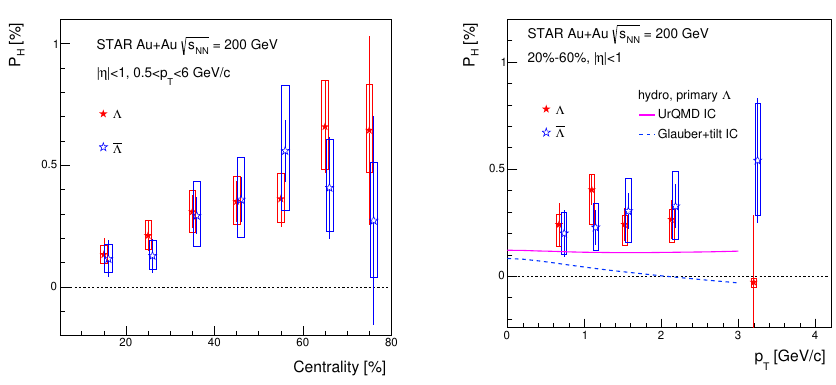
Figure 5. Left. Polarization of Λ and ¯ Λ as a function of the collision centrality in Au + Au collisions √ s NN = 200 GeV. Right. Polarization of Λ and ¯ Λ as a function of transverse momentum p T for the at √ s NN = 200 GeV. Hydrodynamic model calculations 20 – 60% centrality bin in Au + Au collisions at for Λ with two di ff erent initial conditions are compared. Open boxes and vertical lines show systematic and statistical uncertainties. Data points for ¯ Λ are slightly shifted for visibility